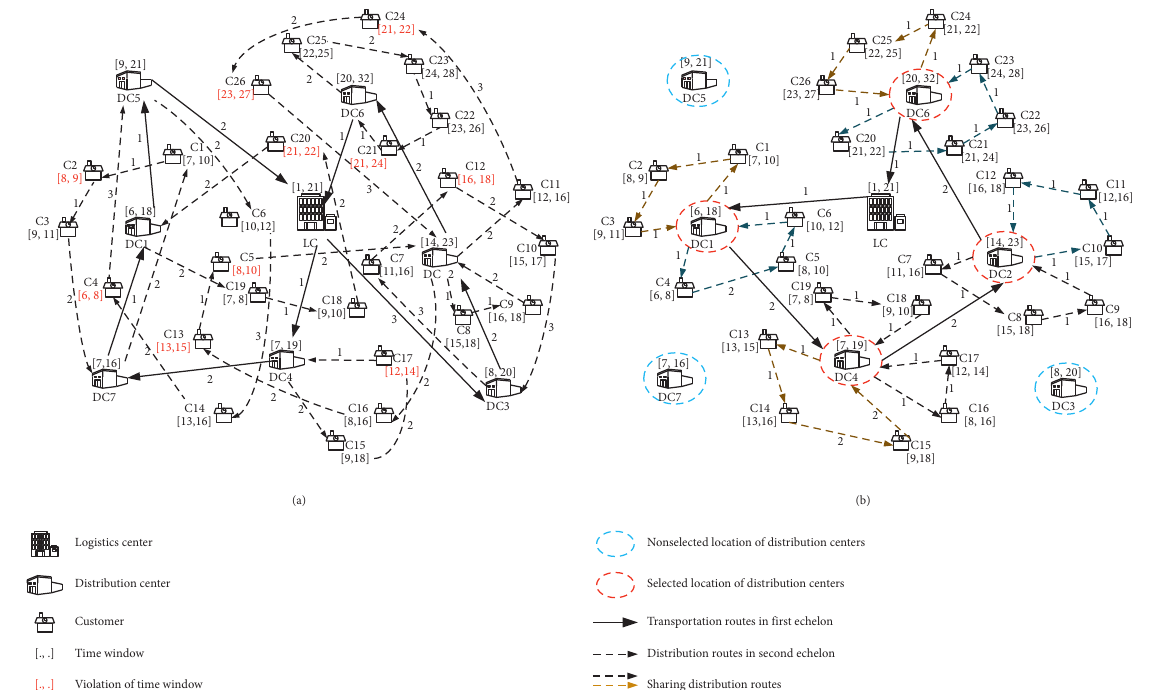
Figure 1: Illustration of 2E-LRPTWTRS optimization. (a) Initial logistics network and (b) optimized logistics